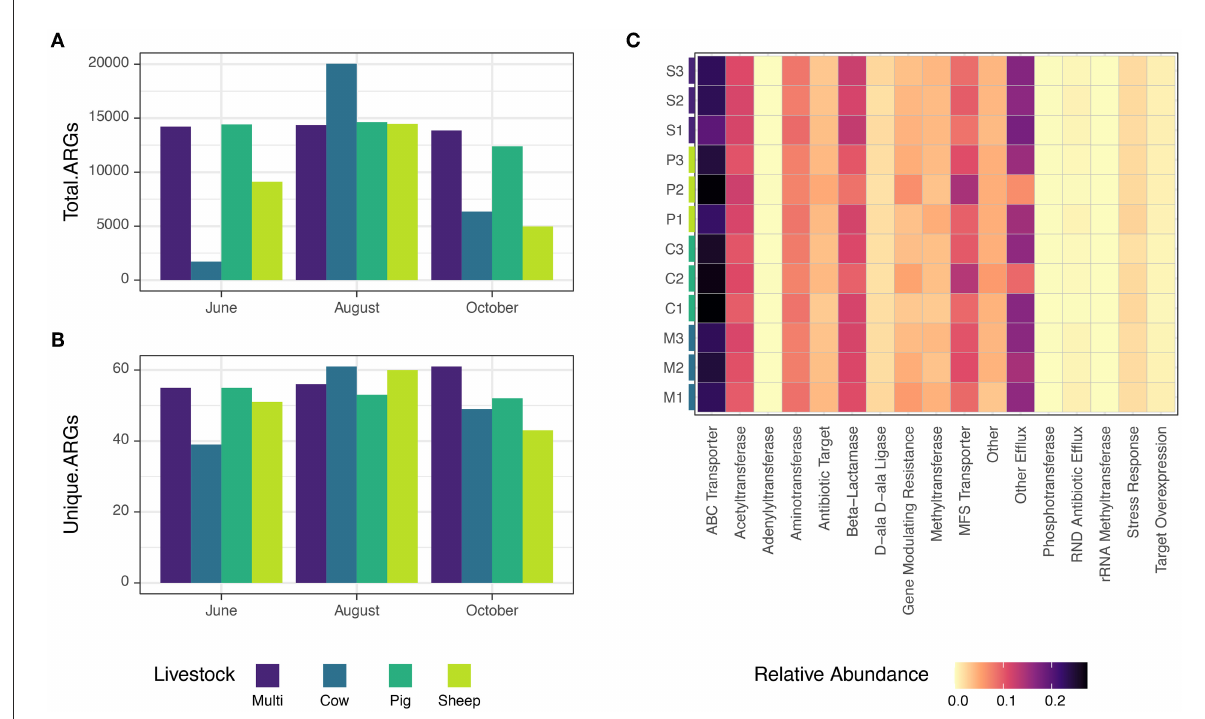
FIGURE8 (A) Abundance of total and (B) unique ARGs observed for each grazing treatment and timepoint. (C) Distribution of antibiotic resistance mechanisms in this study, colored by relative abundance.